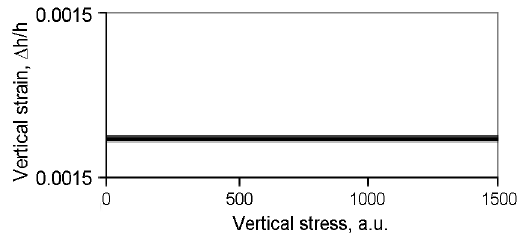
Fig. 17. Vertical stress versus vertical strain via DEM simula- tion